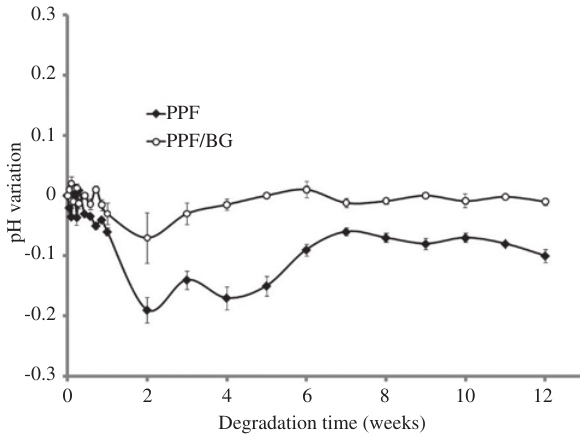
Figure 9 Deviation of Ringer’s solution pH from a blank Ringer’s solution for PPF scaffolds and PPF/BG composite scaffolds groups as a function of degradation time.